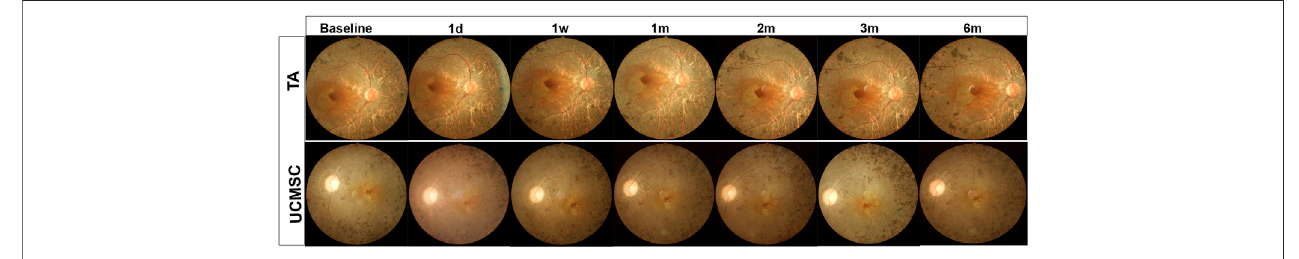
FIGURE2 | Fundusphotograph ofrepresentative RP patient in both groups. The fundus photograph shows typical fundus appearance ofRP, with yellowish color ofopticdisc,thinbloodvessels,grayretinalcolorandosteocytelikepigmentdepositsinperipheralretina.Therewerenoadverseeffectssuchashemorrhage,exudation or in fl ammatory signs found at all follow ups in both groups.